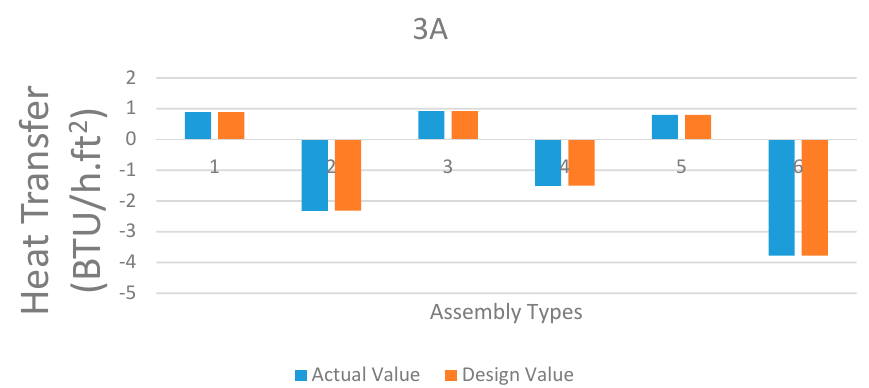
Figure 9. Heat losses in Assembly 3B (with series 1–6 representing the weather conditions as given in Table 8). 4.4. Comparison of 2D (THERM) and 3D (HEAT3) Analysis. However, the results when compared with those of Gulati et al., (2016) [4] and Suddappalli et al., (2016) [5], turned out to be substantially different. The net heat transfer in case of 3D analysis turned out to be comparatively less and the metal deck temperatures were moderate as compared to the 2D THERM analysis. The following Table 9 summarizes the comparison of metal deck temperatures in case of CZ2 (Orlando, FL) zone. Table 9. Difference in metal deck temperatures between HEAT3 (3D) and THERM (2D) Analysis in case of Orlando (CZ2). Area